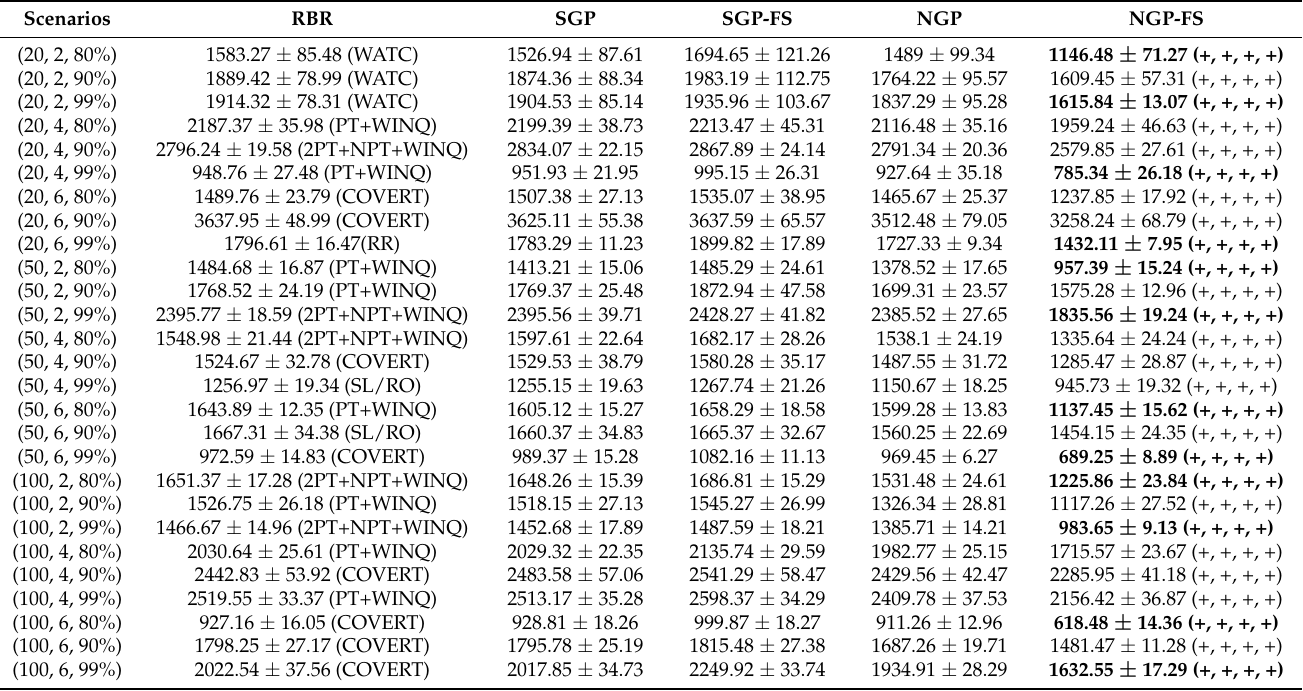
Table 7. Mean and standard deviation of the MWT objective value of the considered algorithms in the testing phase.